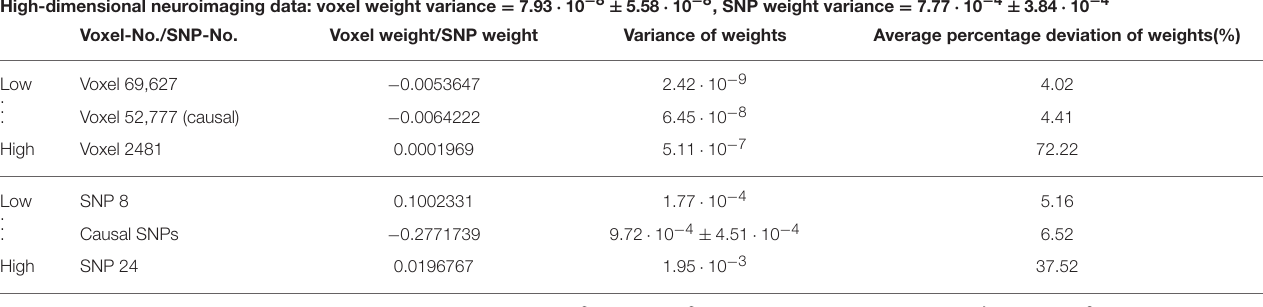
TABLE 6 | Variability of PLSC-RP phenotype and genotype weights. High-dimensional neuroimaging data: voxel weight variance = 7.93 · 10 − 8 ± 5.58 · 10 − 8 , SNP weight variance = 7.77 · 10 − 4 ± 3.84 · 10 − 4